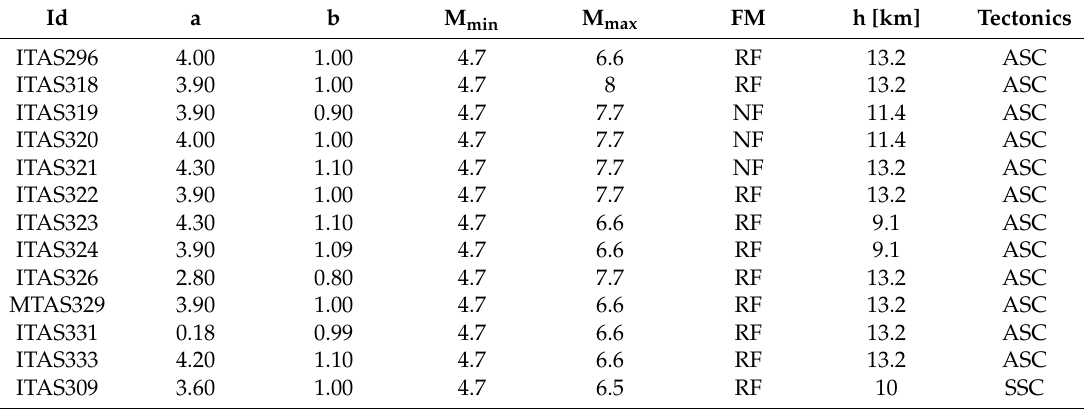
Figure 24. GMPEs used in the logic tree plotted according to the different moment magnitudes (from 4 to 7) and for normal ( a ) and reverse ( b ) faults. Black lines, ITA10 [40]; gray lines, SI1ref; red lines, SI17hyb. SI17ref in panel ( b ) is for the undefined style of faulting. Table 7. Seismic characterization of each SHARE zone [70]. a and b are the parameters of the Gutenberg–Richter distribution. M min and M max are the minimum and maximum moment magnitudes for PSHA. FM: Focal Mechanism; NF: Normal Faulting; RF: Reverse Faulting. h: Reference depth. ASC: Active Shallow Crust; SSC: Stable Shallow Crust. Id